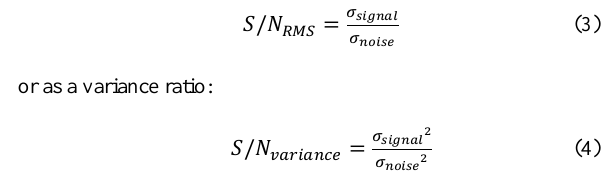
Figure 2.a) Random noise on an image scene, obtained by Canopus-B spacecraft